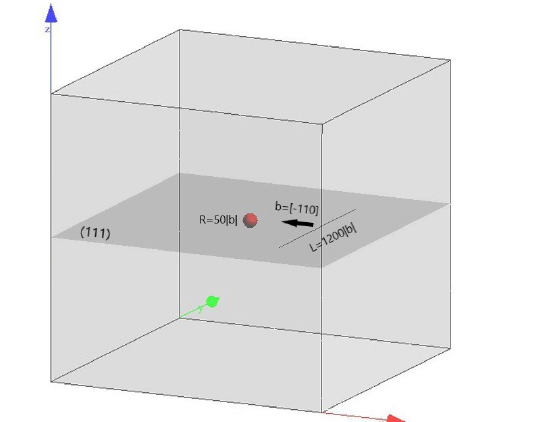
Figure 1. Schematics of the simulation model. The precipitate is represented by the red sphere, the dislocation line is represented by the black line. The light grey volume is the simulation volume, the dark grey plane is the (111) primary slip plane with z / R =